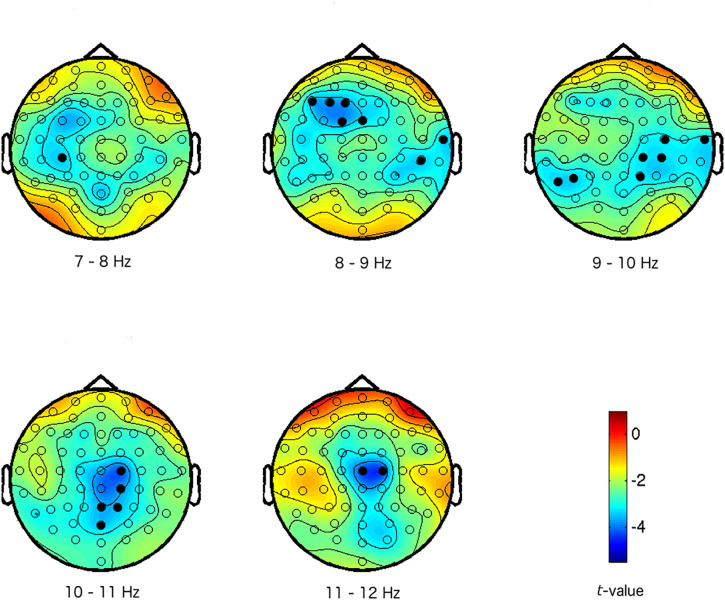
Maps of the difference between high and low arousal IAPS pictures in activity in the alpha frequency band (7–12 Hz). The colors represent t-values. The different scalp maps show the contrast (expressed in t-values) between high and low arousal for the specific frequencies that are mentioned below the maps, and across the head for the 64 electrodes. Electrodes with activations above the threshold are marked in black (i.e., electrodes that are part of the arousal effect/cluster/F-ROI: preset cluster inclusion for data points p < 0.005, cluster significance p < 0.01 FWE).